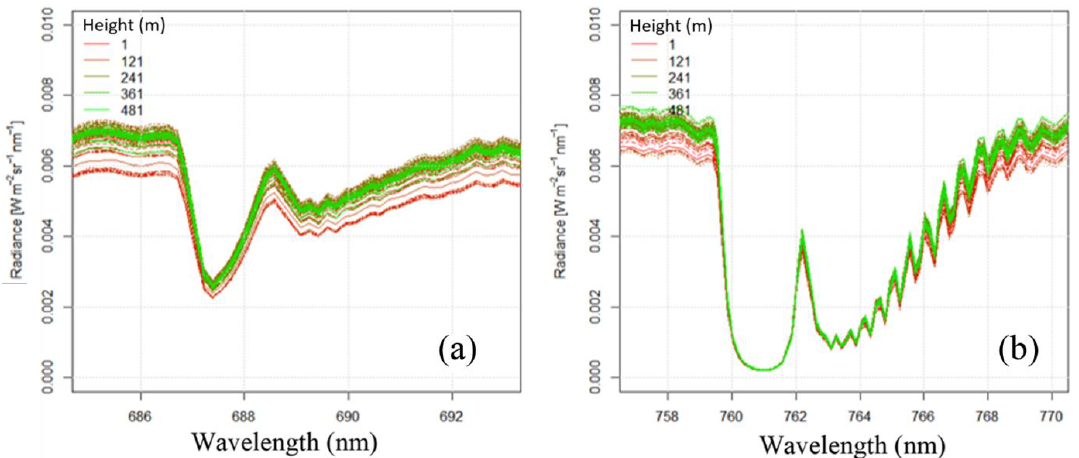
Figure 7. Zoom to the ( a ) O 2 -B and ( b ) O 2 -A at sensor radiance spectra of the first flight of the FloX-Plane UAS [36].